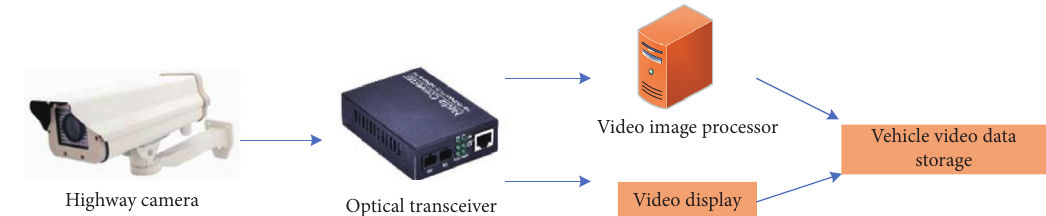
Figure 6: High-speed vehicle abnormal driving detection system structure based on high-definition video under the background of the integration of the Internet of Things and 5G.